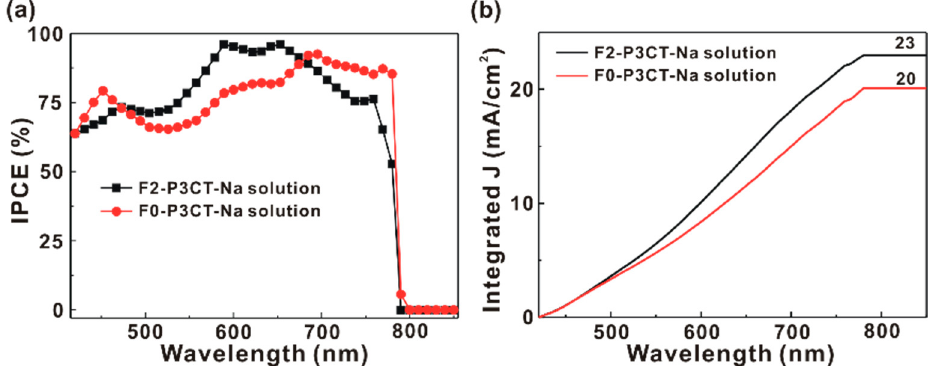
Figure 10. ( a ) Incident photon-to-current conversion efficiency spectra of the P3CT-Na based MAPbI 3 solar cells. ( b ) Integrated photocurrent density (J) of the P3CT-Na based MAPbI 3 solar cells.